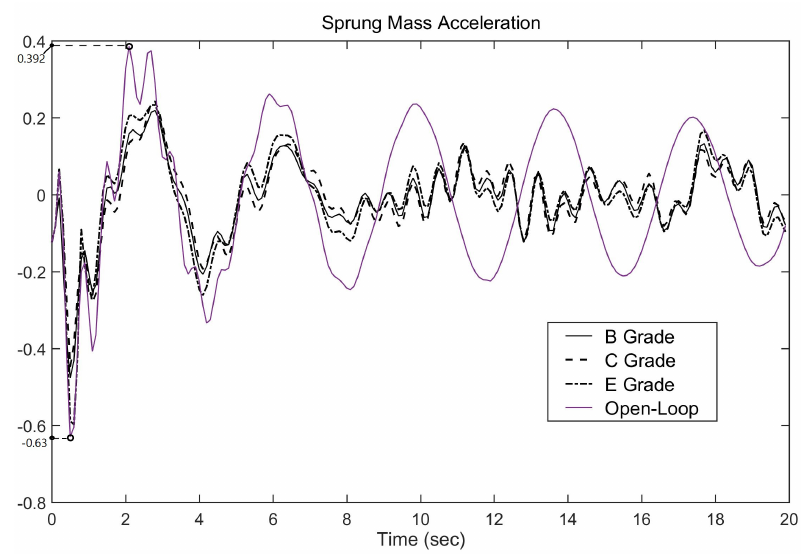
Figure 3. The comparison curves of SMA under different road roughnesses.